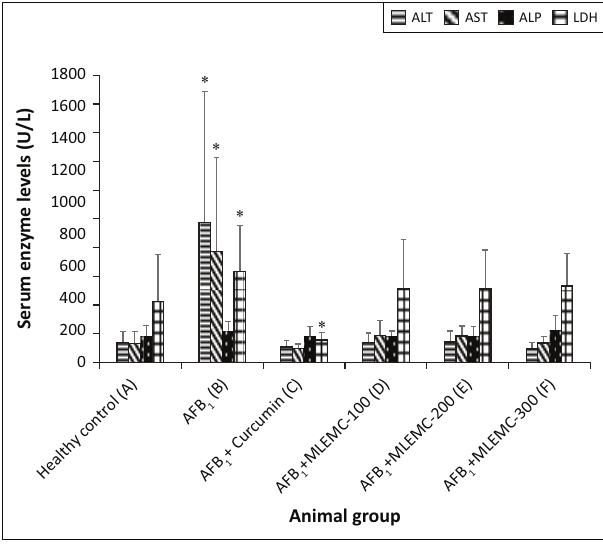
FIGURE 1: Effect of Methanolic leaf extracts of M. caffra on the serum levels of alanine aminotransferase, aspartate aminotransferase, alkaline phosphatase activities and lactate dehydrogenase following aflatoxin B induced hepatoxicity in